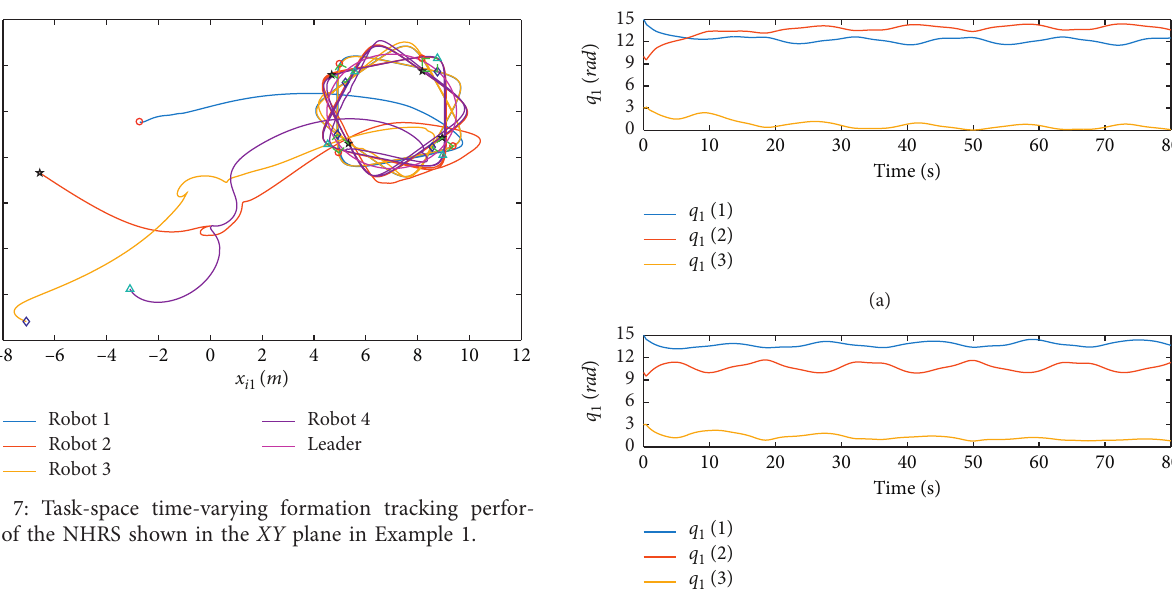
􏽢 v − _ h i 1 i 1 (c), and